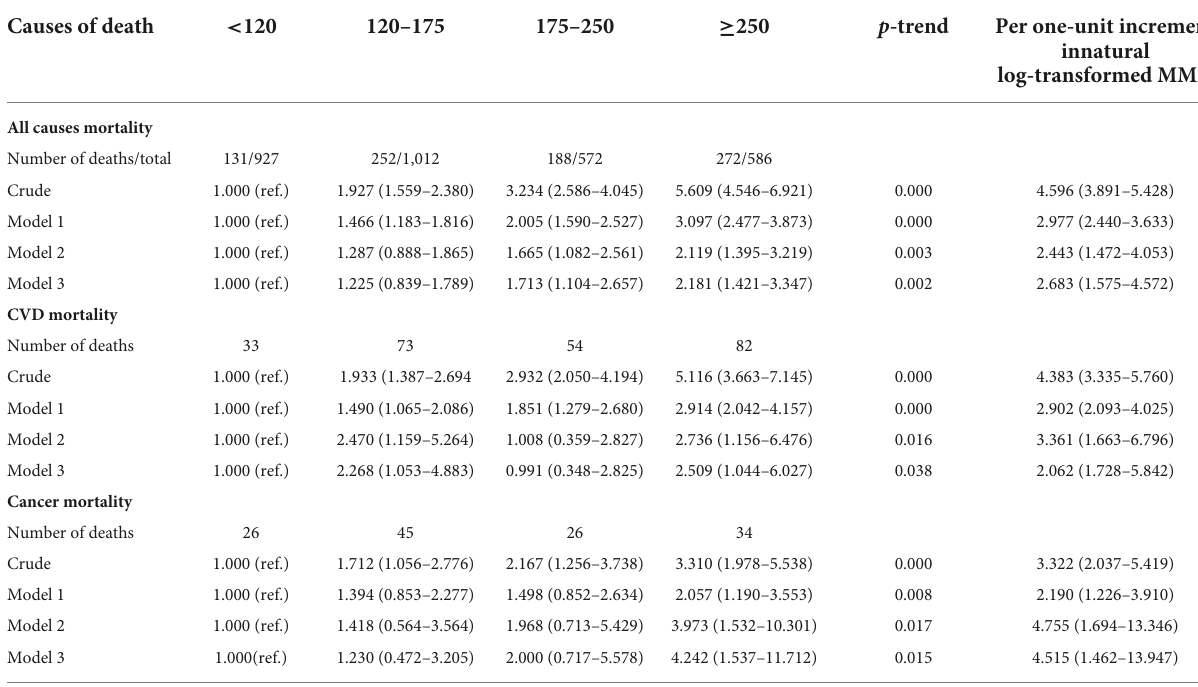
TABLE 2 Hazard ratio (HR) (95% confidence intervals [CIs]) for all-cause and cause-specific mortality according to serum methylmalonic acid (MMA) concentrations among patients with diabetes in National Health and Nutrition Examination Survey